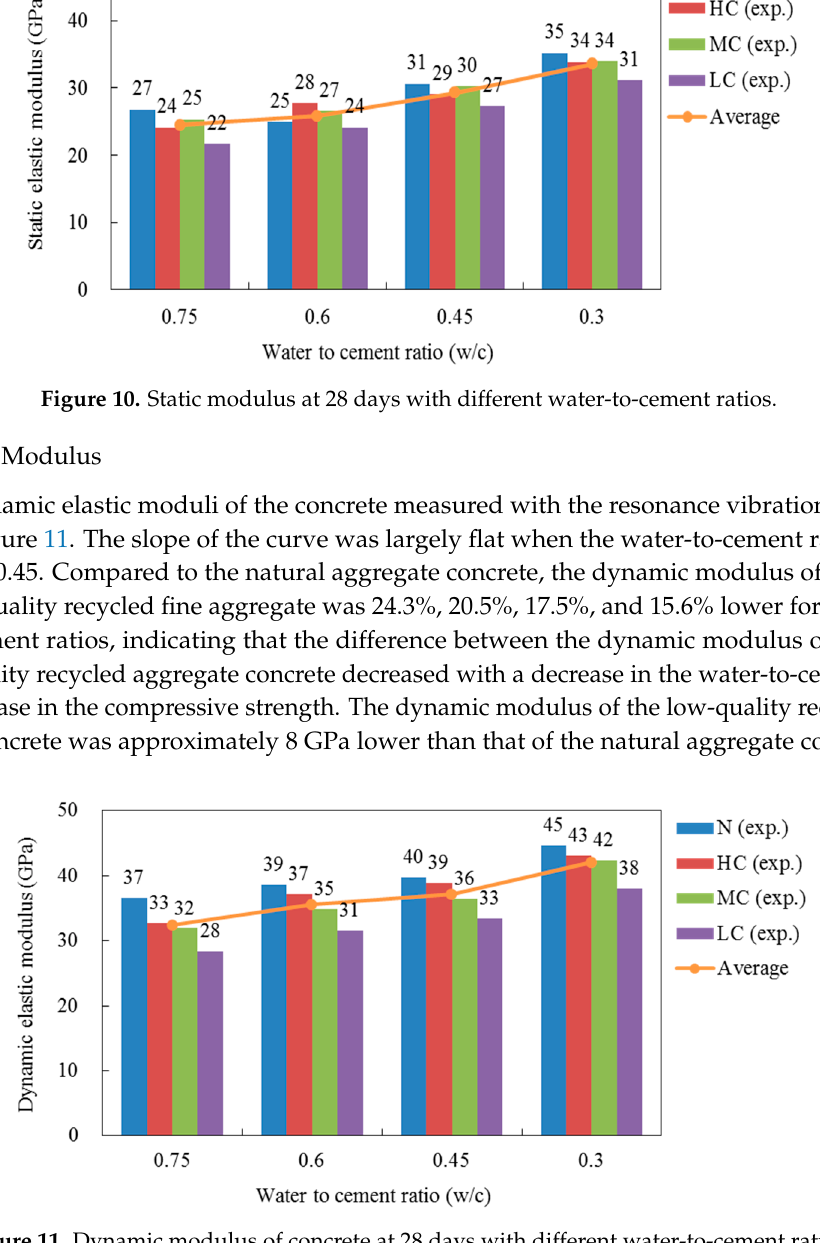
Figure 9. Split tensile strength of concrete with different water-to-cement ratios.